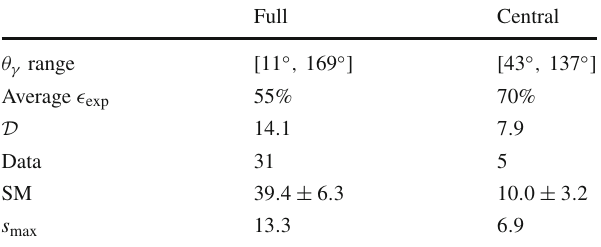
Table 7 LEP data, expected number of events and corresponding CLs limit for the multi-photon selection for the two considered angular ranges for the photons. We also list the considered average detector efficiencies